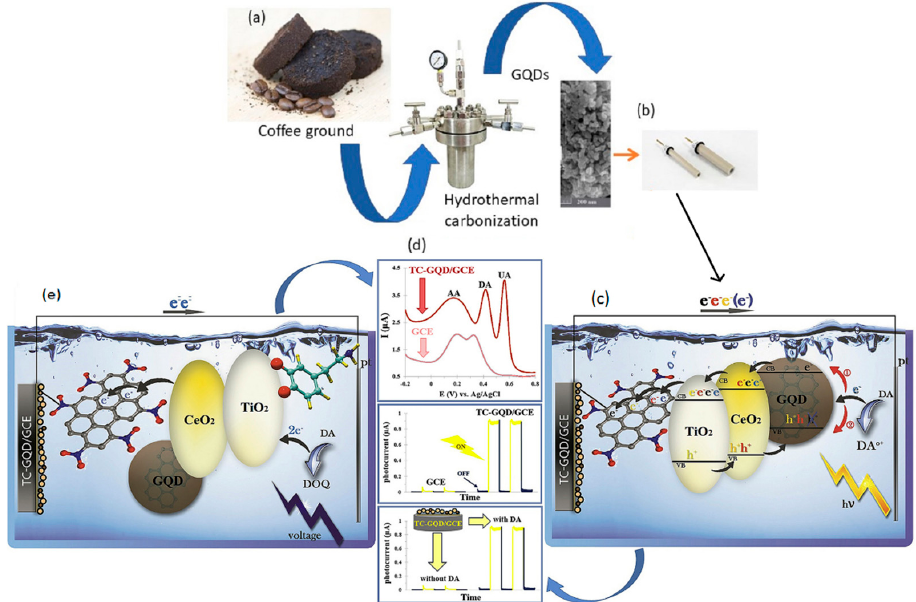
Figure 3. Electrochemical and photo electrochemical detection of dopamine on titania–ceria–graphene quantum dots nanocomposite. ( a ) GQD synthesis by hydrothermal carbonization process; ( b ) Fabrication of the EC and PEC electrodes by modification with the TC ‐ GQD; ( c ) Schematic representation of the EC electron transfer mechanism at TC ‐ GQD/GCE in the presence of DA; ( d ) Differential pulse voltammetry (DPV) of TC ‐ GQD/GCE and photocurrent responses of the TC ‐ GQD/GCE; ( e ) Schematic representation of the PEC electron transfer mechanism at TCGQD/GCE in the presence of DA. Adapted with the permission of Ref. [127].